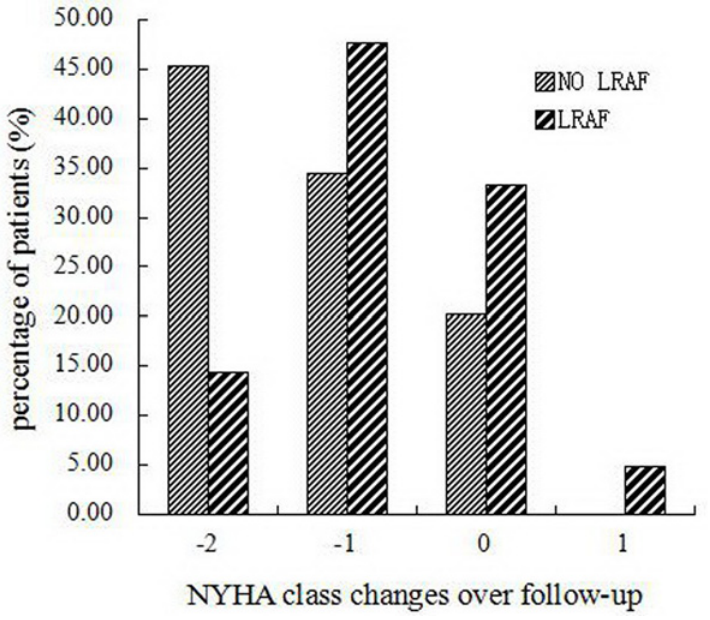
Fig 3. Comparison of NYHA class changes in patients with and without LRAF. Decrease in NYHA class after BRFA were significantly greater in patient without LRAF ( p = 0.006). BRFA: bipolar radiofrequency ablation; LRAF: late recurrence of AF; NYHA: New York Heart